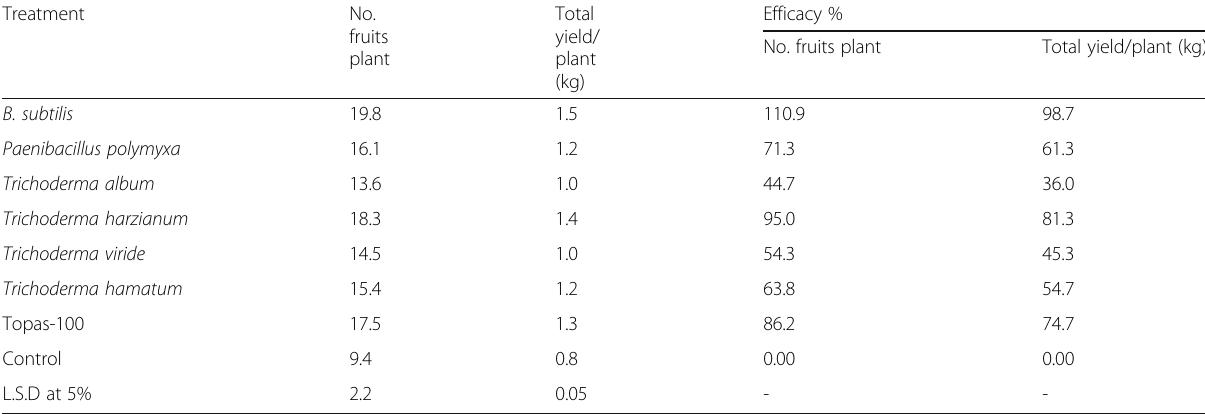
Table 4 Effect of bio-agents on the total yield/plant of squash plants under greenhouse